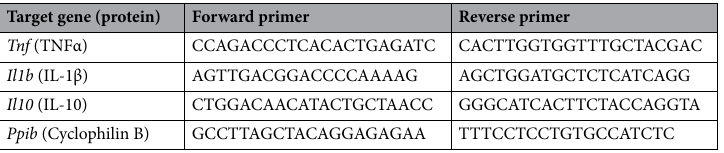
Table 1. Sequences of the primers used in this